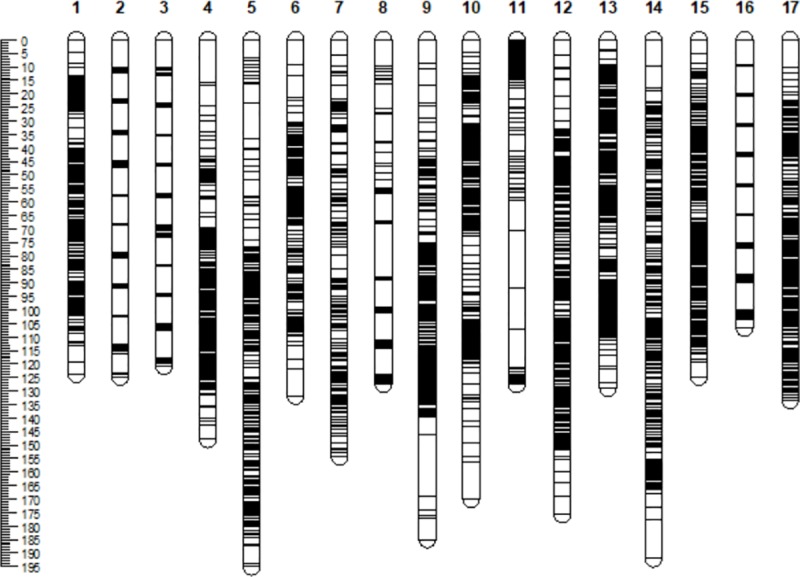
Marker distribution and genetic length of integrated map.Centimorgans (cM) indicated the genetic length of vertical scale. Black lines represent mapped markers. LG1–17 represents corresponding linkage groups.